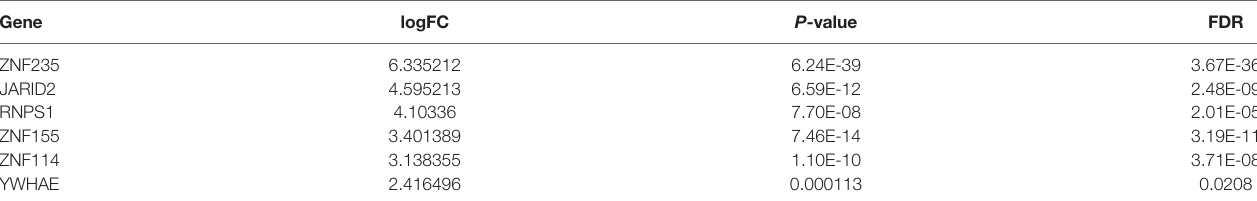
TABLE 5 | Six genes were found to be upregulated in TPC-1-Lv-FTO and vector cell lines by meRIP-Seq sequencing [logFC >1, p < 0.05, false discovery rate (FDR) <0.05]. Gene logFC P